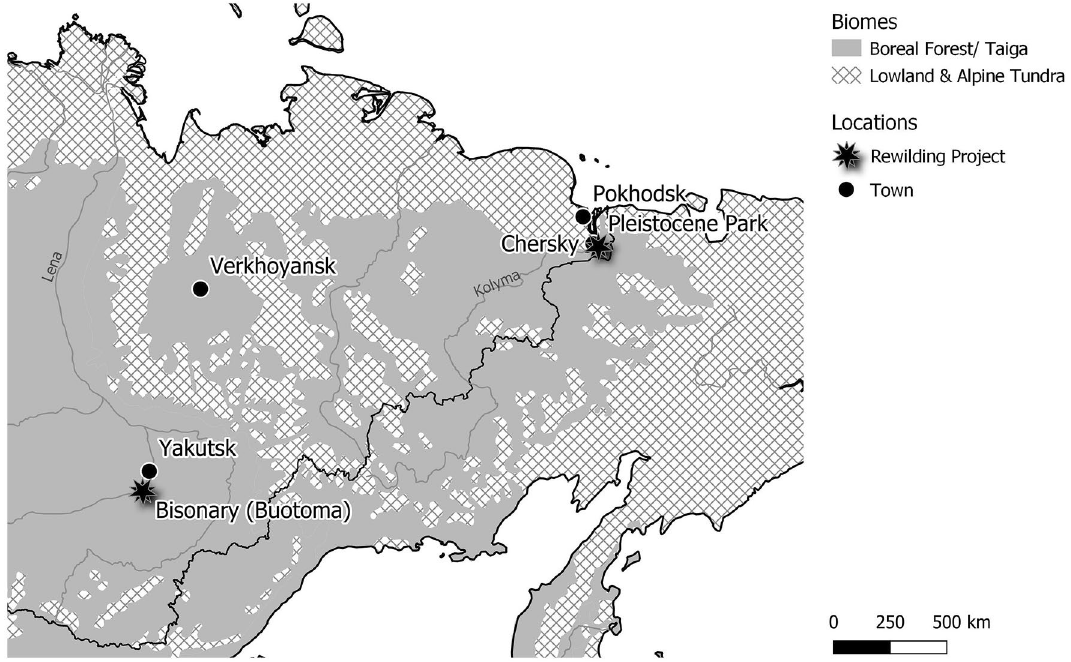
Figure 2. Map of the study area. Physical Map: made with Natural Earth; Biomes: adapted from https:// ecore gions 2017. appsp ot. com/.